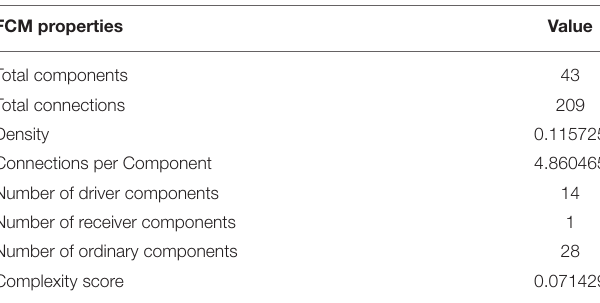
TABLE 1 | General FCM